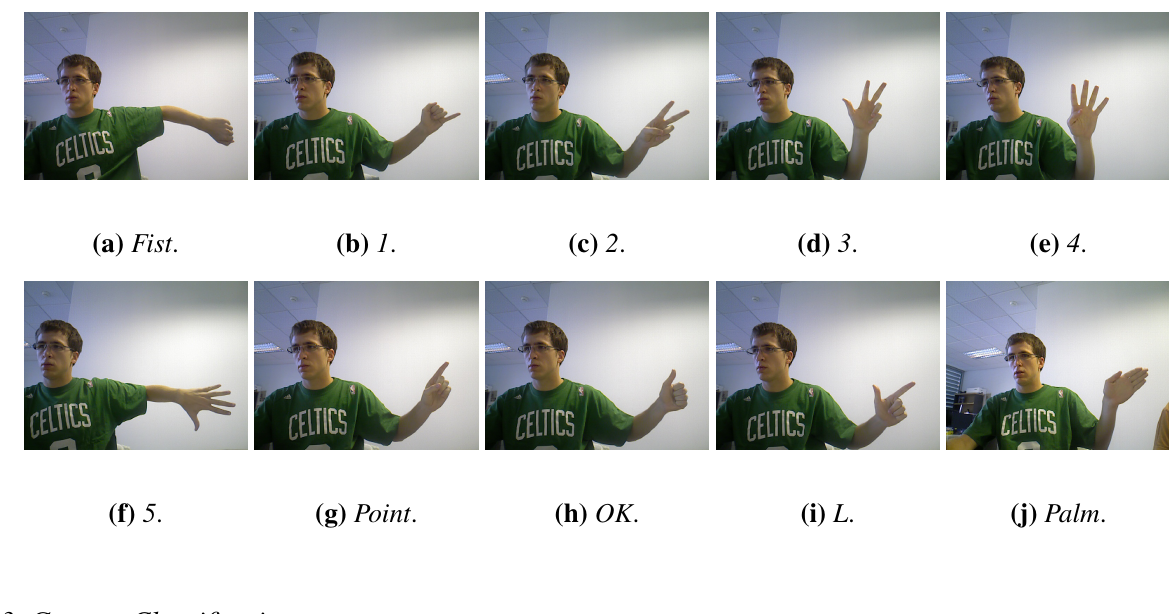
Figure 7. Examples of the ten gestures available in the